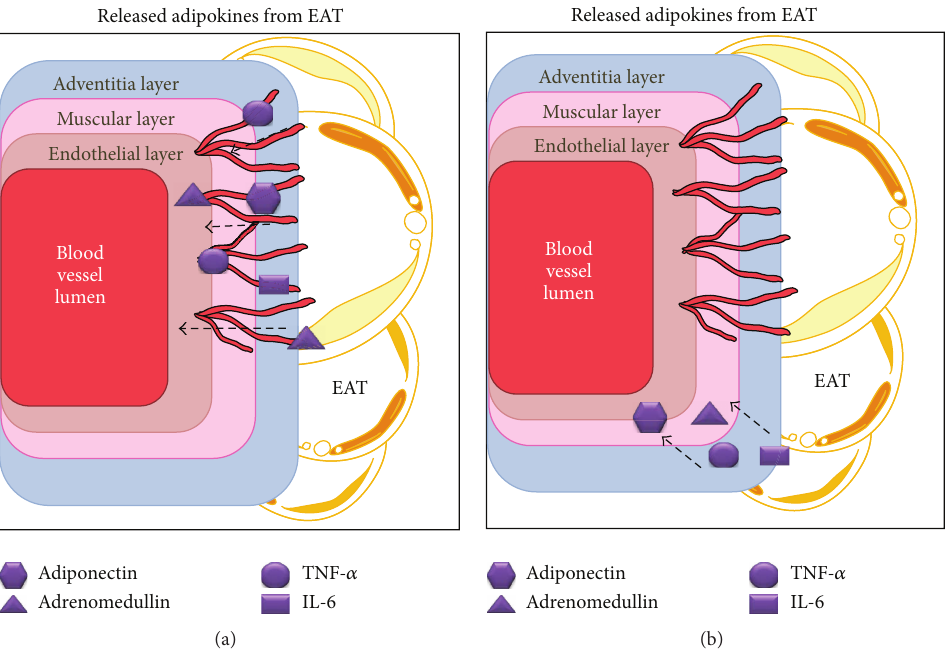
Figure 1: EAT secretion mechanism. Adipokines entering the wall by a “vasocrine” mechanism (a) using as transportation vasa vasorum or using a paracrine mechanism (b), which through dissemination adipokines pass down the gradient of concentration. The molecules continue to step up to the deeper layers of blood vessels (endothelial and muscular) which trigger several effects. EAT: epicardial adipose tissue, TNF- 𝛼 : tumoral necrosis factor alpha, and IL-6: interleukin